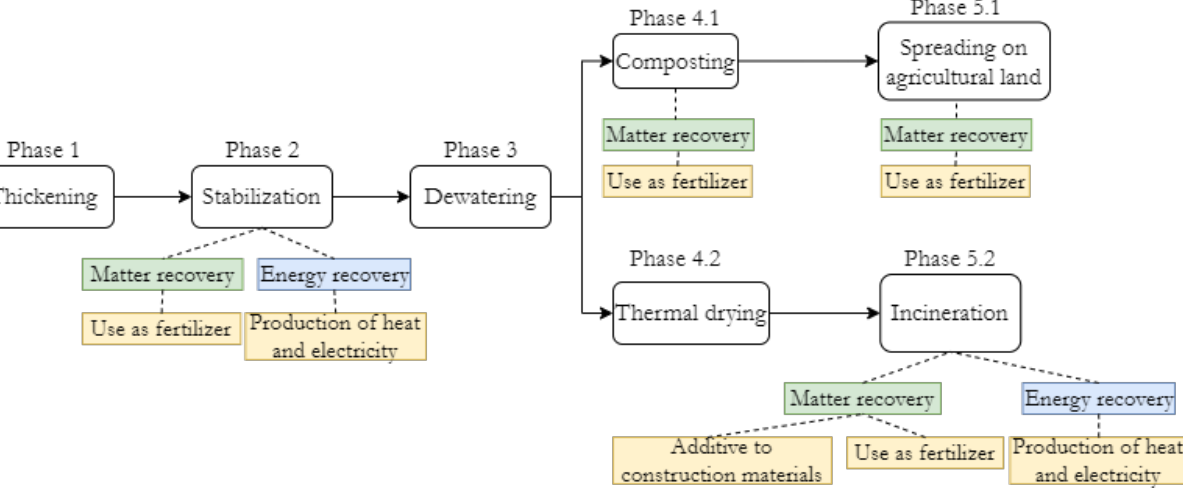
Figure 1. Framework of the sewage sludge treatment system (SSTS) considered by the present study with the indication of energy and matter recoveries, which are achieved within each phase.